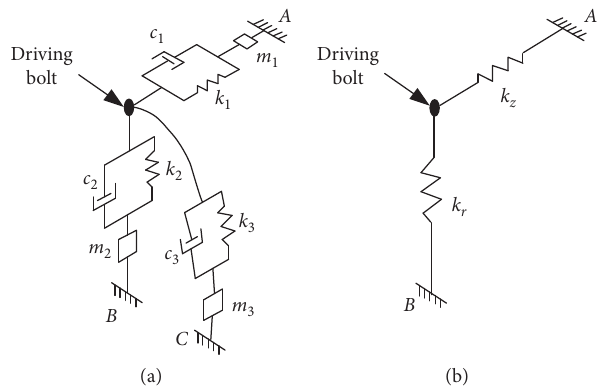
Figure 6: The mathematical model of the diaphragm group. (a) The 3-DOF model. (b) The simplified